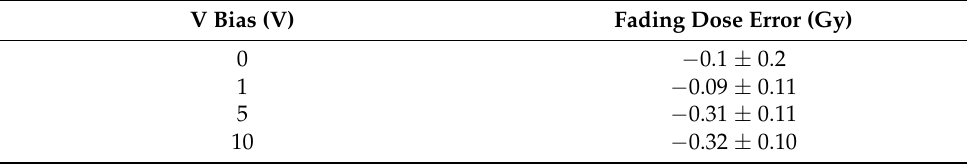
Table 2. Error dose due to the fading